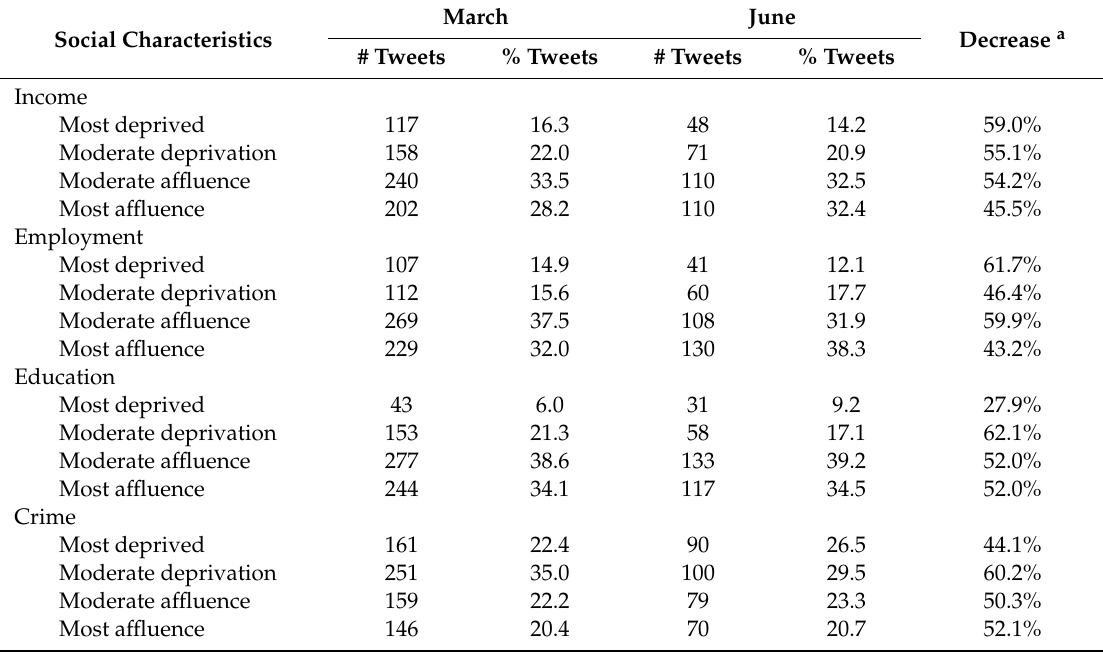
Table 3. Descriptive statistics of the social characteristics of the LSOAs in tweeting